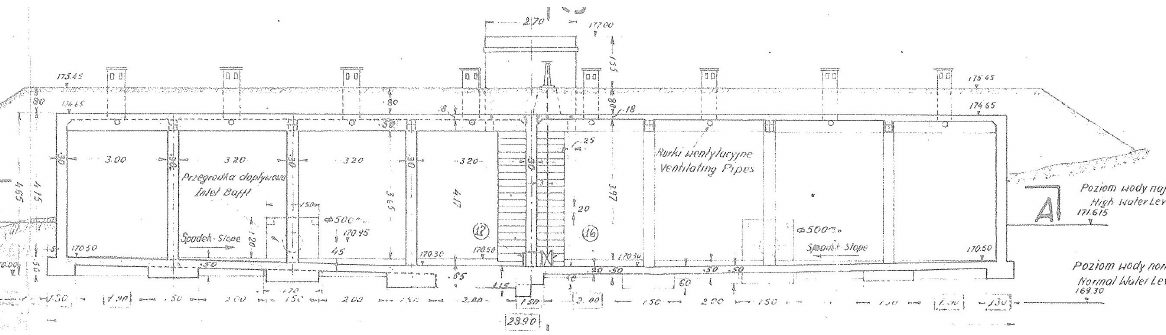
Figure 3: The location of water tank in relation to the river and the buildings of water supply plant with the scheme of geotechnical layers.